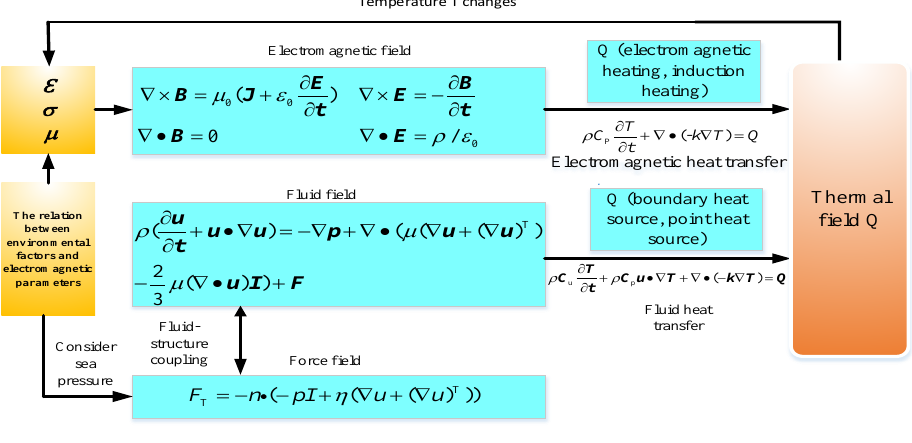
Figure 2. Multiphysics coupling relationship diagram .